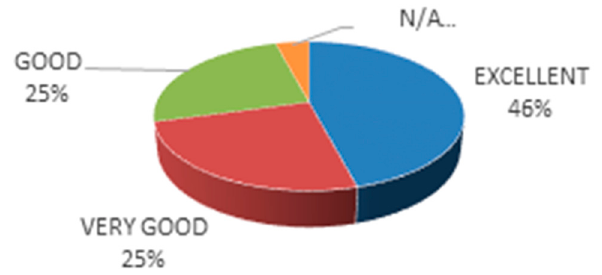
Figure 9. Evaluation of the testbed integration. Assessment of ease of setting up and deployment.